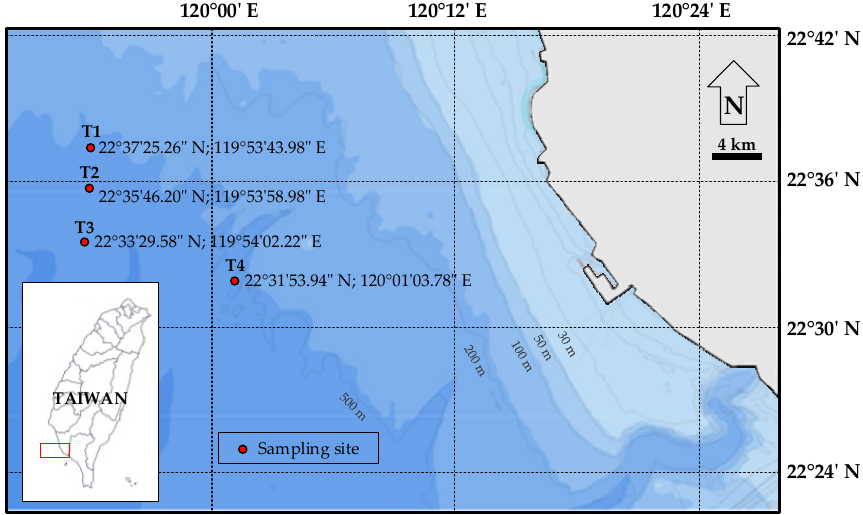
Figure 1. Map of the study area and sampling sites.